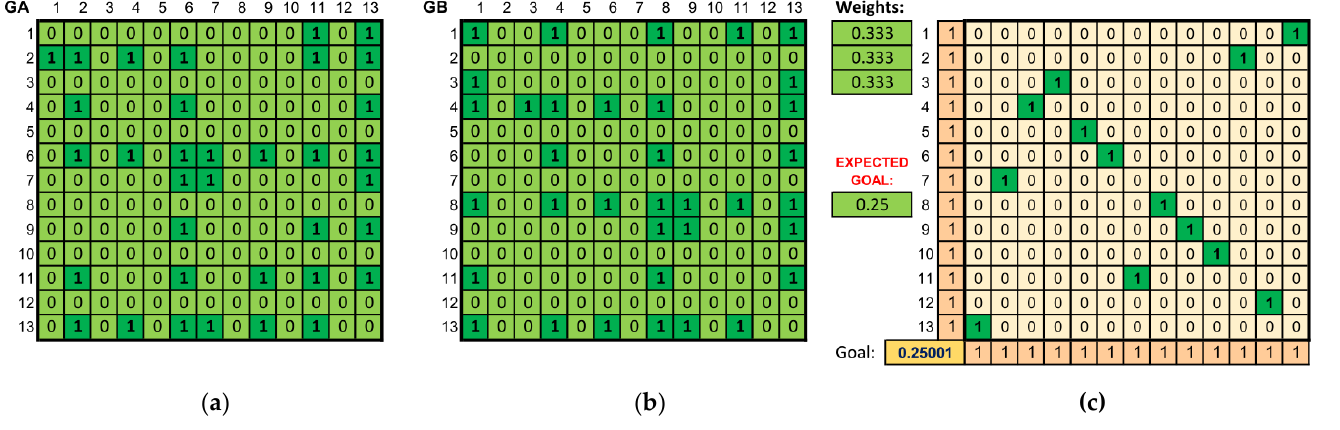
Figure 6. Comparison of Für Elise in the original version and the arrangement generated on its basis. ( a ) The adjacency matrix of the graph representing the original piece. ( b ) The adjacency matrix of the graph representing the arrangement. ( c ) The calculated assignment matrix of vertices from one graph to another (maximizing graph similarity) together with the value of the objective function.